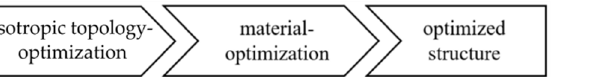
Figure 2. Typical procedure for the optimization of hybrid structures reinforced with cFRP [3]. In a first step, isotropic topology optimization is performed. In a second step, the orientation of the anisotropic material within the resulting volume is optimized.